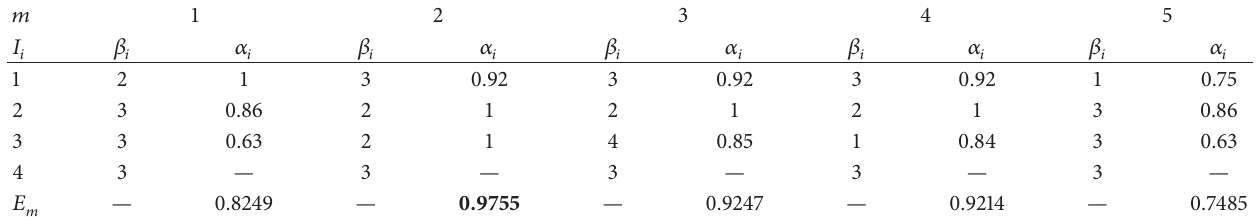
Table 7: Selected solutions of different phase sequences on Kietzke Lane (2nd Street → Plumb Lane).